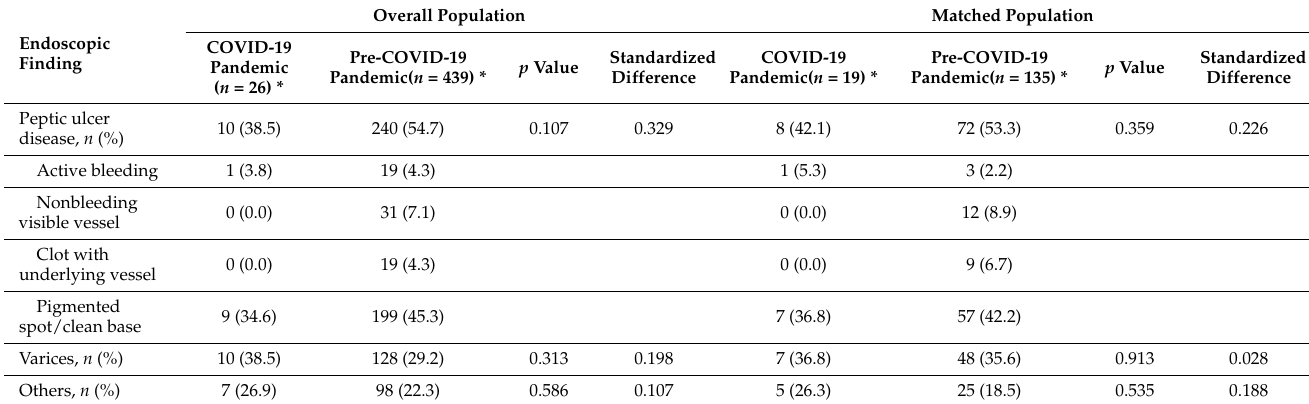
Table 6. Endoscopic findings among the overall and matched